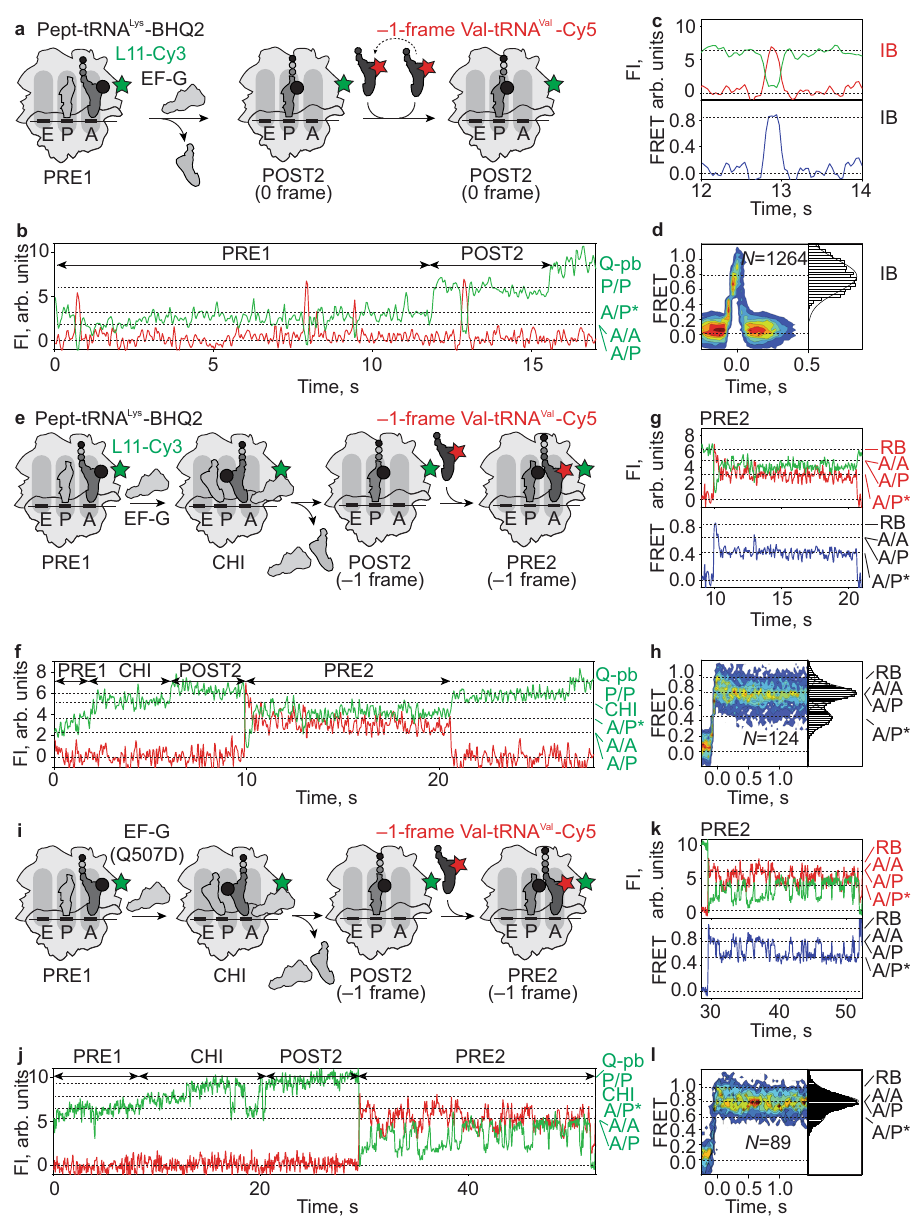
Fig. 3 Translocation of pept-tRNA Lys on slippery mRNA and incorporation of 0- and – 1-frame aa-tRNAs. a Schematic of translocation on slippery mRNA with EF-G(wt). Pept-tRNA Lys -BHQ2 (black circle) moves from the A to the P site. The near-cognate – 1-frame Val-tRNA Val -Cy5 (red star) samples POST2 complexes without accommodating in the A site. EF-G is added to immobilized PRE1 complexes together with the EF-Tu – GTP – Val-tRNA Val -Cy5 complex. b Representative time trace of pept-tRNA Lys -BHQ2 movement and subsequent sampling of POST2 complexes by Val-tRNA Val -Cy5 ( N = 89). Fl, fl uorescence intensity; Q-pb, photobleaching of BHQ2. Green labels at the right Y-axis indicate tRNA Lys conformational states monitored by Cy3 fl uorescence, as assigned in Supplementary Fig. 4. c Zoom-in into b showing Cy3 and Cy5 FI and calculated FRET of the initial binding (IB) without accommodation of – 1-frame Val-tRNA Val -Cy5 on POST2 complexes. d Contour plot showing distribution of FRET values during – 1-frame Val-tRNA Val - Cy5 sampling of POST2 complexes. Traces were synchronized to the point with FRET > 0. Histogram at the right shows FRET distribution after synchronization. e Schematic of translocation on slippery mRNA by EF-G(wt), with − 1 frameshifting. After translocation of pept-tRNA Lys -BHQ2 (black circle) from the A to the P site and Val-tRNA Val -Cy5 (red star) can bind to its cognate – 1-frame codon. f Representative time trace of pept-tRNA Lys -BHQ2 translocation and accommodation of Val-tRNA Val -Cy5 ( N = 57). g Zoom-in into f showing Cy3 and Cy5 FI and calculated FRET of Val-tRNA Val -Cy5 binding to POST2 forming PRE2 complexes. Red labels indicate conformational states of tRNA Val -Cy5. h Contour plot showing distribution of FRET values after Val- tRNA Val -Cy5 accommodation on POST2 complex forming PRE2. i Schematic of translocation on slippery mRNA by EF-G(Q507D), with − 1 frameshifting. After translocation of pept-tRNA Lys -BHQ2 from the A to the P site, Val-tRNA Val -Cy5 (red star) accommodates on its cognate codon in – 1-frame. j Representative time trace of pept-tRNA Lys -BHQ2 translocation and subsequent accommodation of – 1-frame Val-tRNA Val -Cy5 (box) ( N = 46). k Zoom-in into k showing Cy3 and Cy5 FI and calculated FRET of Val-tRNA Val -Cy5 binding to POST2 complex, leading to CR and subsequent fl uctuations between A/ A, A/P and A/P* states. l Contour plot showing the distribution of FRET values after Val-tRNA Val -Cy5 accommodation on POST2